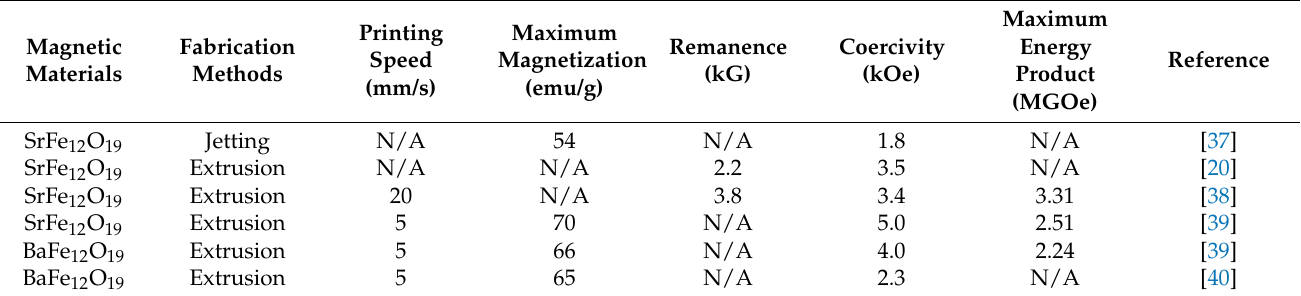
Table 3. Magnetic properties of 3D-printed hard